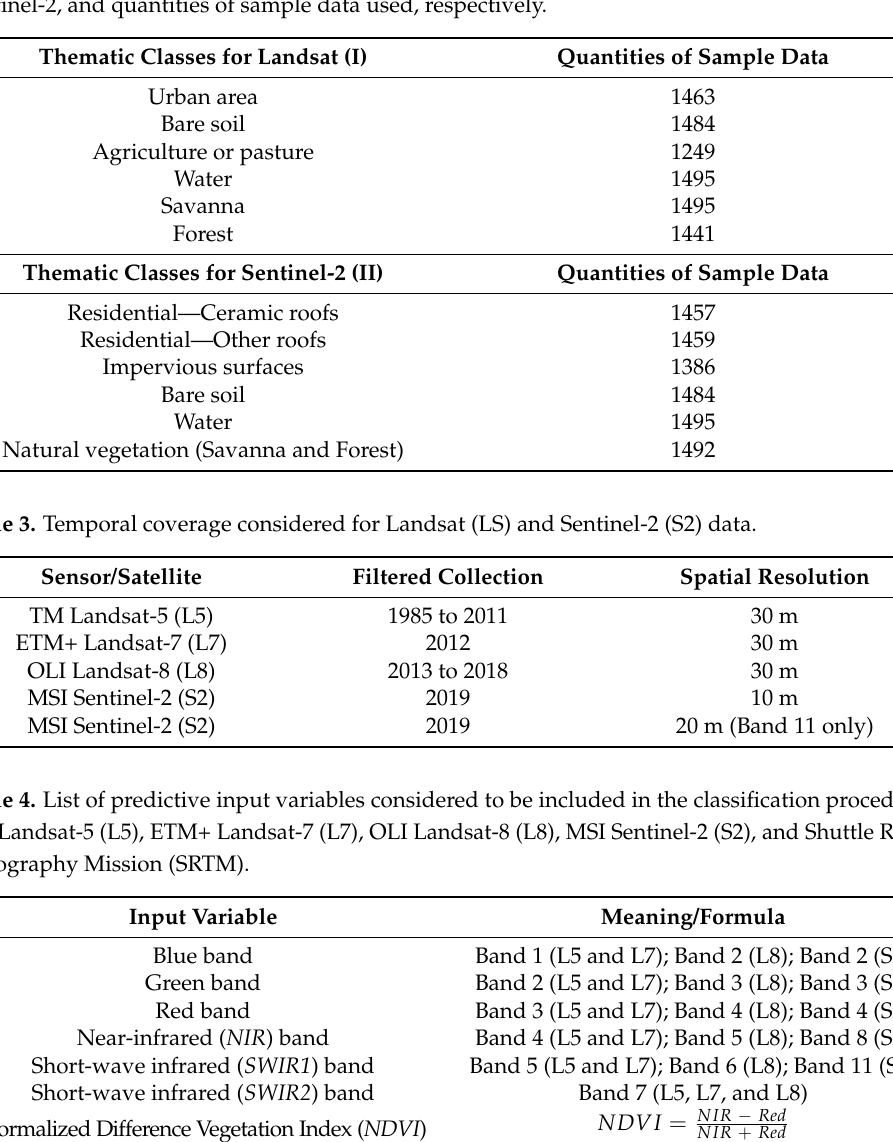
Table 2. List of the thematic LULC classes used with each remote sensing dataset—Landsat and Sentinel-2, and quantities of sample data used, respectively.